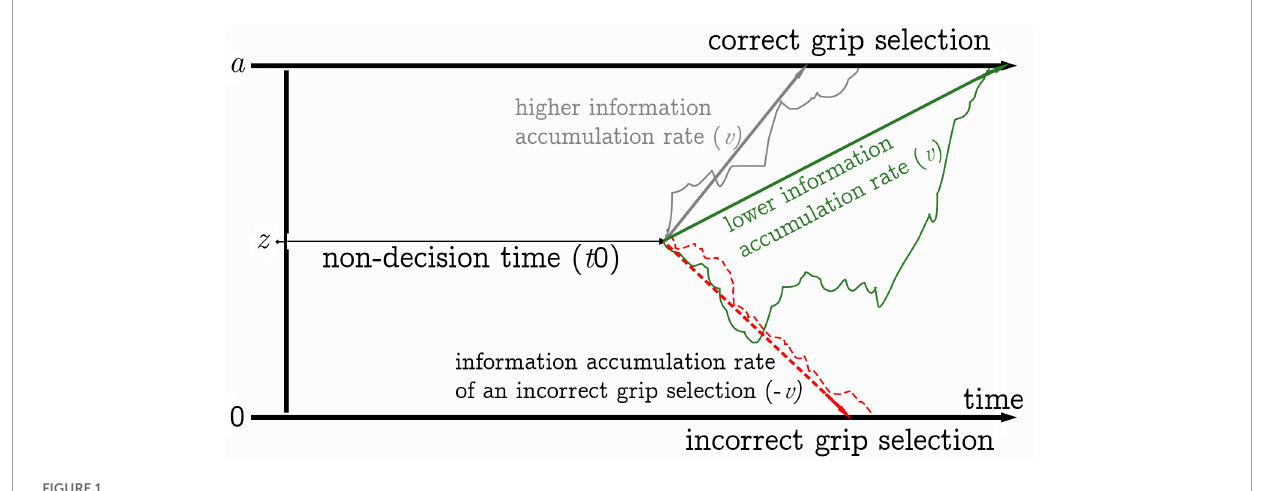
FIGURE1 Graphical representation of the drift diffusion model